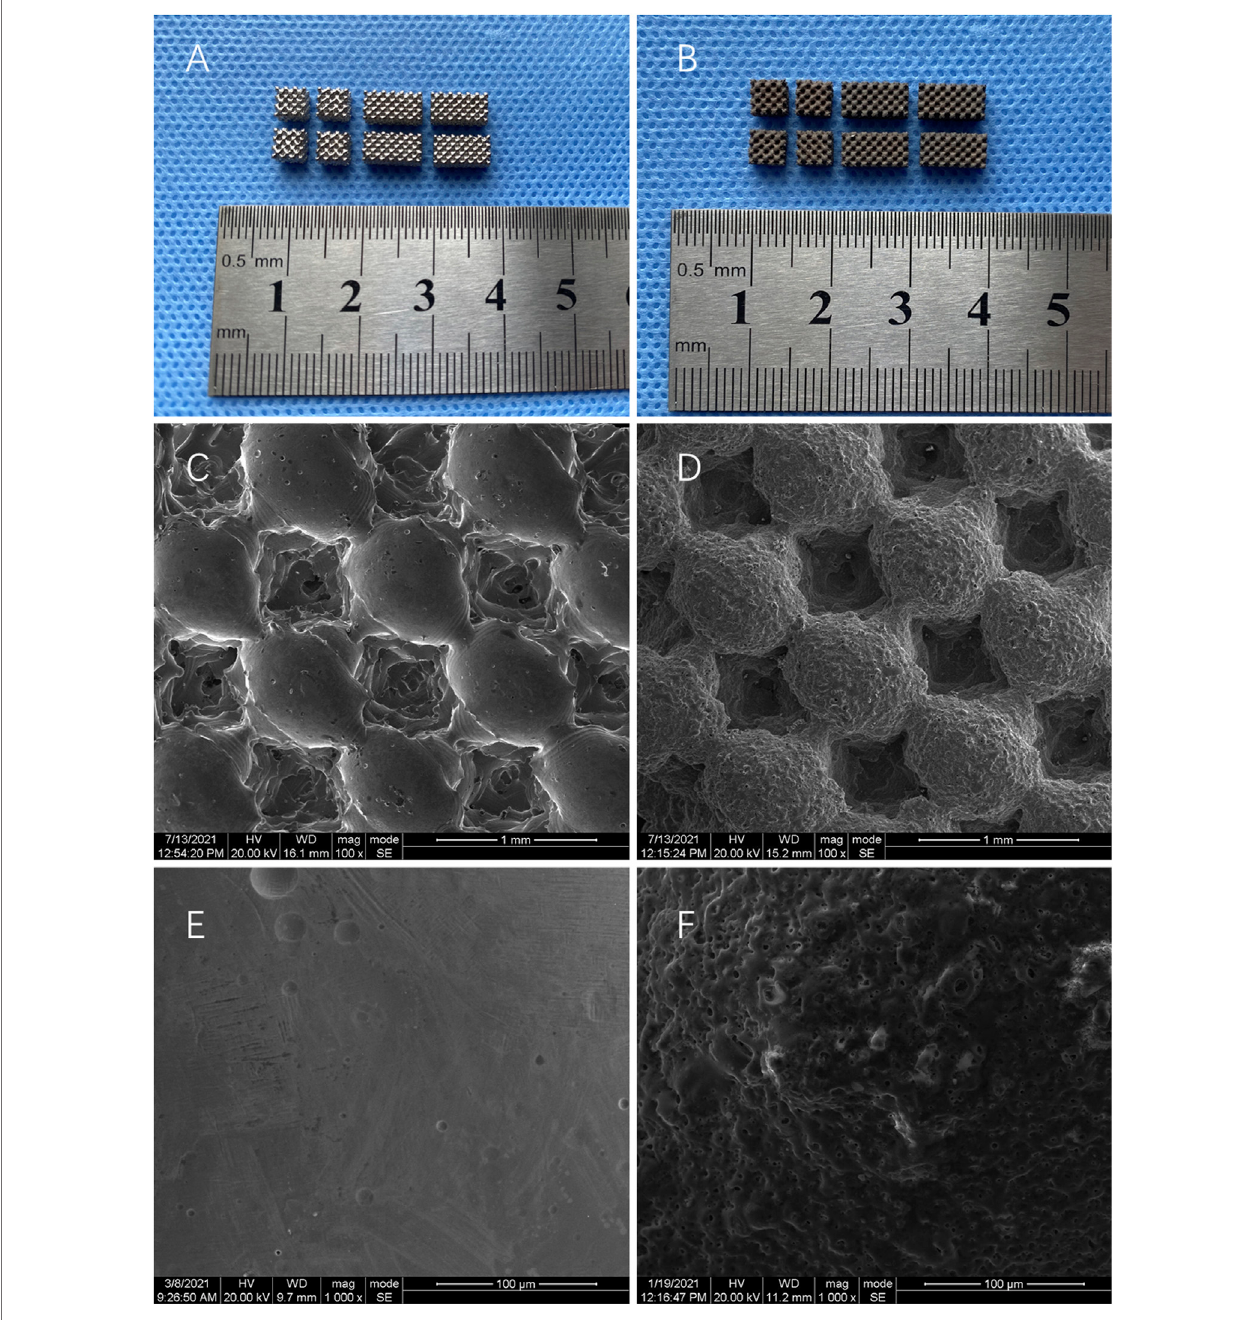
FIGURE 1 | General observation: (A) Ti; (B) Gr-Ti; SEM observation: (C,E) Ti; (D,F) Gr-Ti.